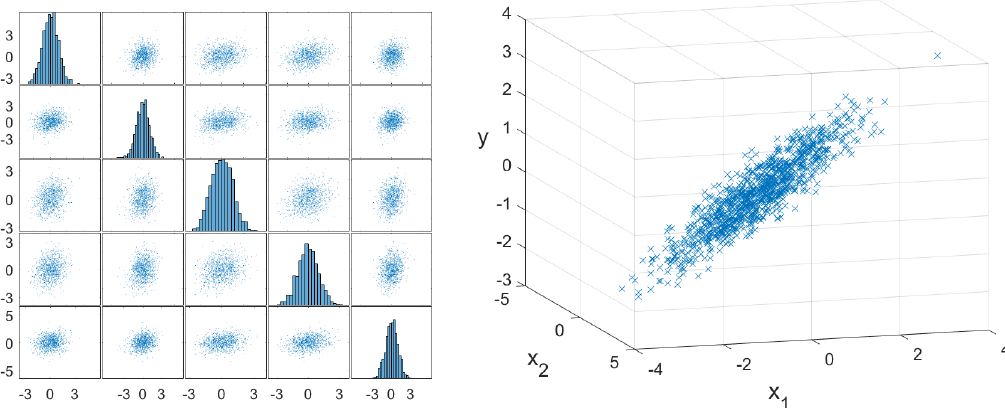
Figure 2. Scatter plots of the predictor matrix X , showing bivariate relationships and the distributions of the variables x 1 , x 2 ... x 5 on the diagonal from top left to bottom right ( left ) and a 3D scatter plot of the simulated data set, y = f ( x 1 , x 2 ) ( right). Random forest models were fitted to the data, with the following optimal parameters: 𝑚 (cid:3047)(cid:3045)(cid:3052) = 2 , 𝑛 = 80% of the data, minimum leaf size, 𝑛 = 5. On average, the random forest model (cid:3047)(cid:3045)(cid:3052) (cid:3039)(cid:3032)(cid:3028)(cid:3033)